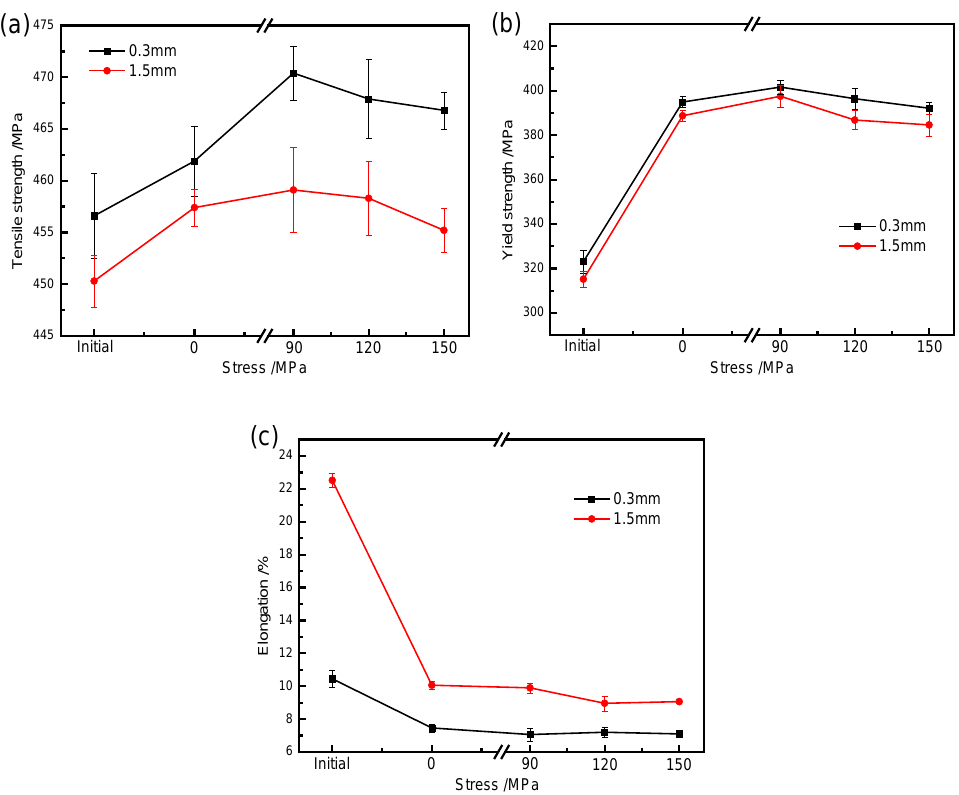
Figure 5. The mechanical properties of initial state AA2024 and AA2024 aged at 453 K under various stresses: ( a ) tensile strength; ( b ) yield strength; and ( c ) elongation. As a complement to the mechanical analysis, an SEM analysis was performed to ob- tain more information on the tensile fracture morphology of specimens with different